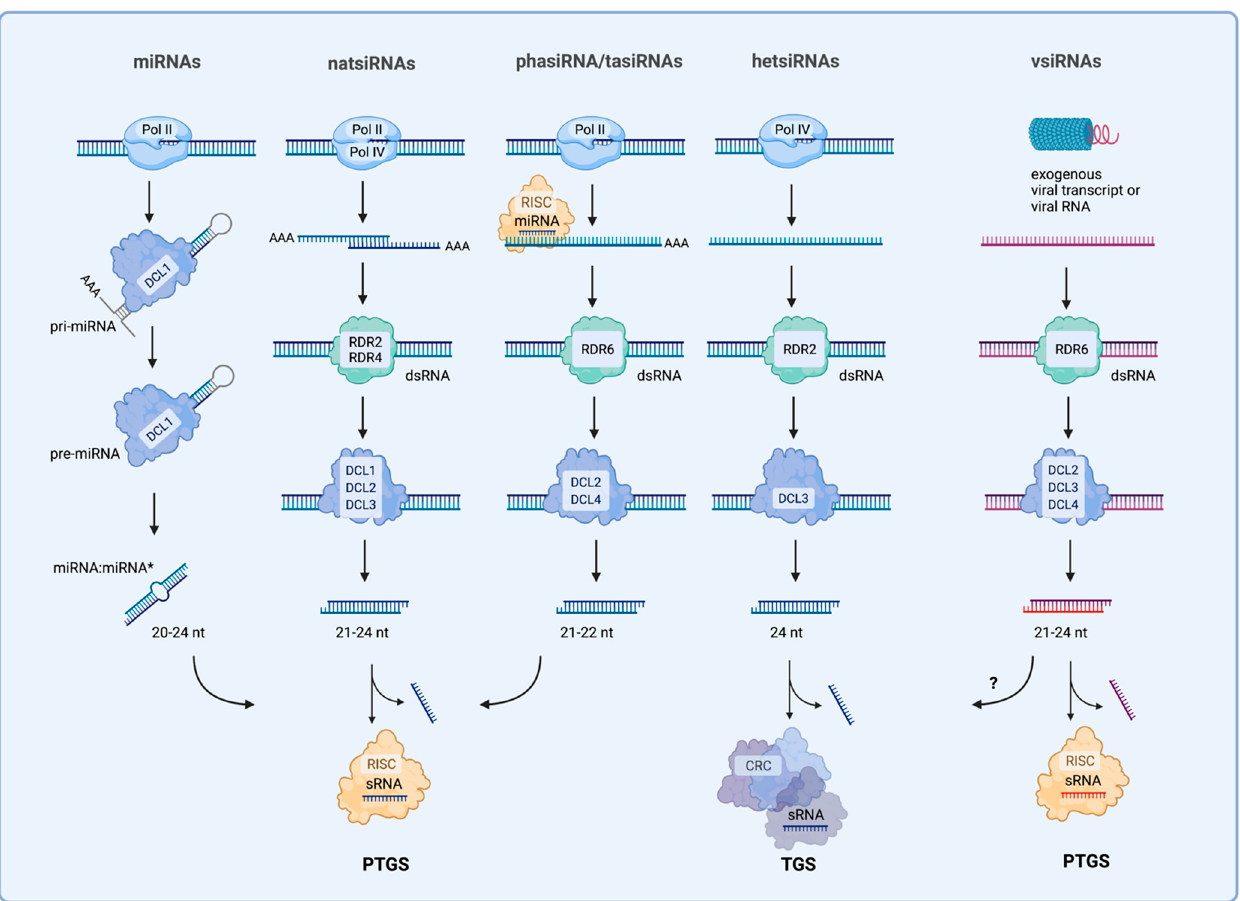
Figure 1. Biogenesis pathways of endogenous and exogenous small RNAs in plants. A majority of miRNAs are encoded by their own genes and transcribed by Pol II. Primary transcripts (pri-miRNA) are processed by DCL1, producing the miRNA hairpin precursor (pre-miRNA), which is further cleaved by DCL1 to generate a miRNA:miRNA* duplex. Unlike miRNAs, the other plant small RNAs are not encoded by genes. Instead, natsiRNAs originate from overlapping transcripts; secondary small RNAs originate from noncoding or coding loci, or TE; and hetsiRNA are transcribed from TE and repeat elements of pericentromeric chromatin. Downstream, the resulting transcripts (including the exogenous viral transcripts and viral RNAs) fall into processing pathways to generate double- stranded RNAs by RDRs, which are cleaved into small RNAs by DCLs. Small RNAs are loaded into an RNA-induced silencing complex (RISC), triggering posttranscriptional gene silencing—PTGS (miRNAs, natsiRNAs, secondary siRNA, vsiRNAs)—or into chromatin remodelling complexes (CRC) to induce transcriptional gene silencing—TGS—by RNA-dependent DNA methylation—RdDM (hetsiRNAs, vsiRNAs). (Created with BioRender.com, accessed on 27 March